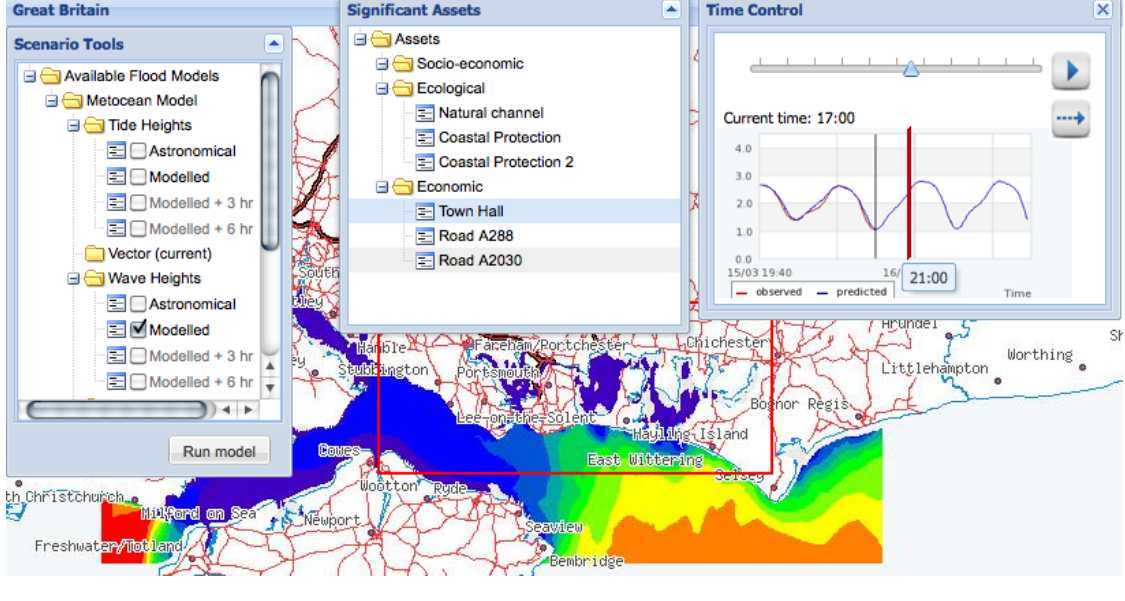
Figure 11. Screenshot displaying the output of the wave height flood model (Section